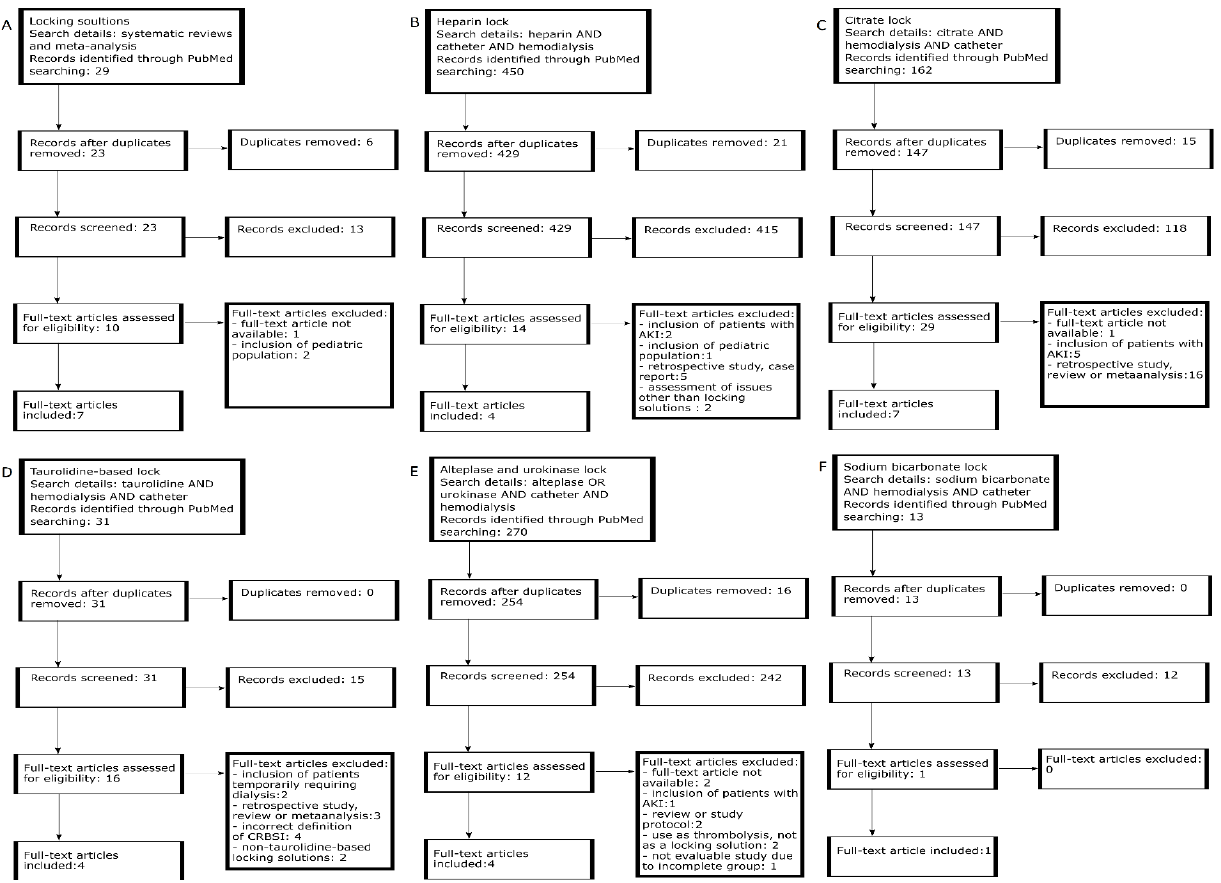
Figure 1. PRISMA flowcharts showing the search strategy and results: A—systematic reviews and meta-analysis; B—heparin lock; C—citrate lock; D—taurolidine-based lock; E—alteplase and urokinase lock; F—sodium bicarbonate lock. List of abbreviations used—AKI- Acute Kidney Injury